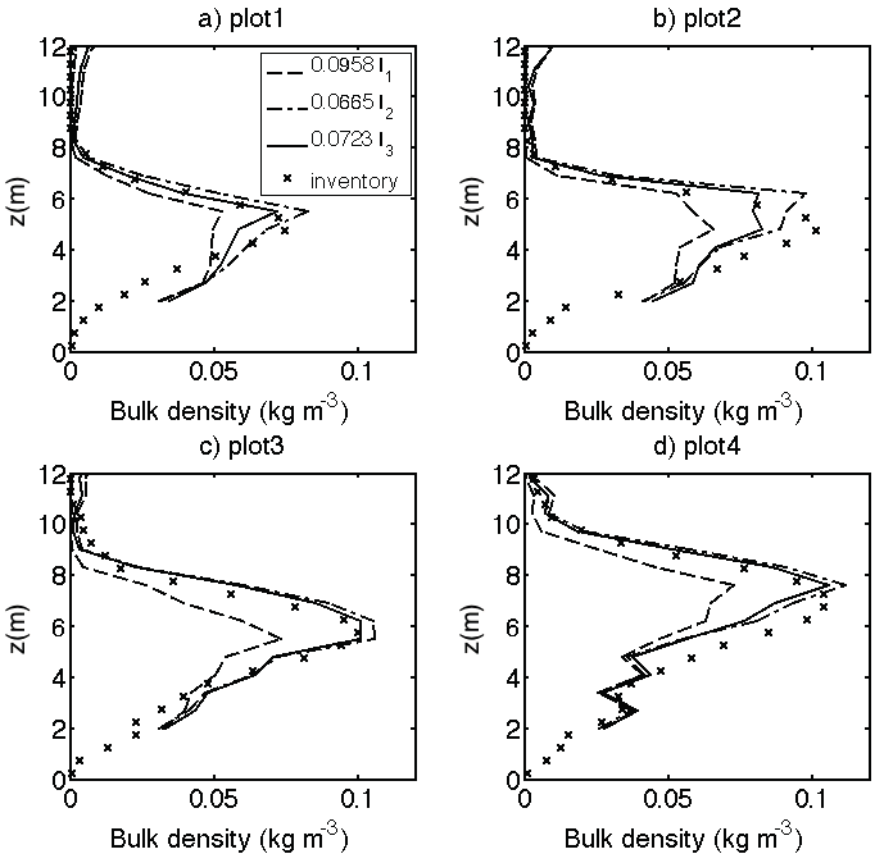
Figure 8. Leaf bulk density profiles estimated from TLS- and inventory-based methods: ( a ) Plot 1; ( b ) Plot 2; ( c ) Plot 3 and ( d ) Plot